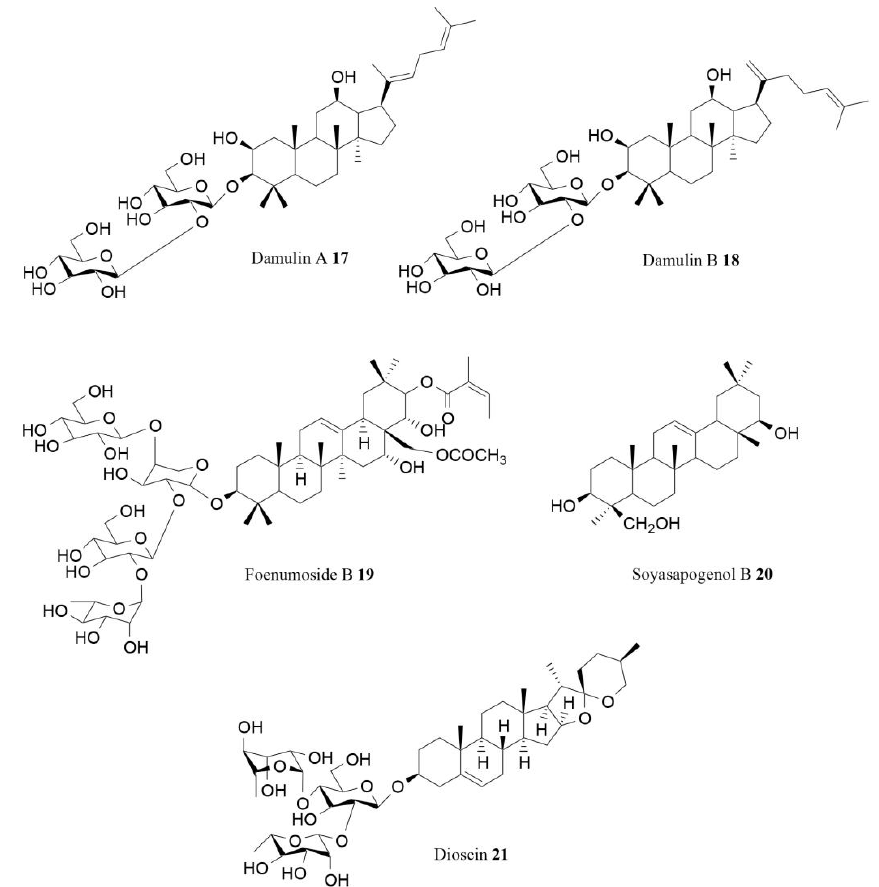
Figure 5. Saponins activating AMPK [78–81].